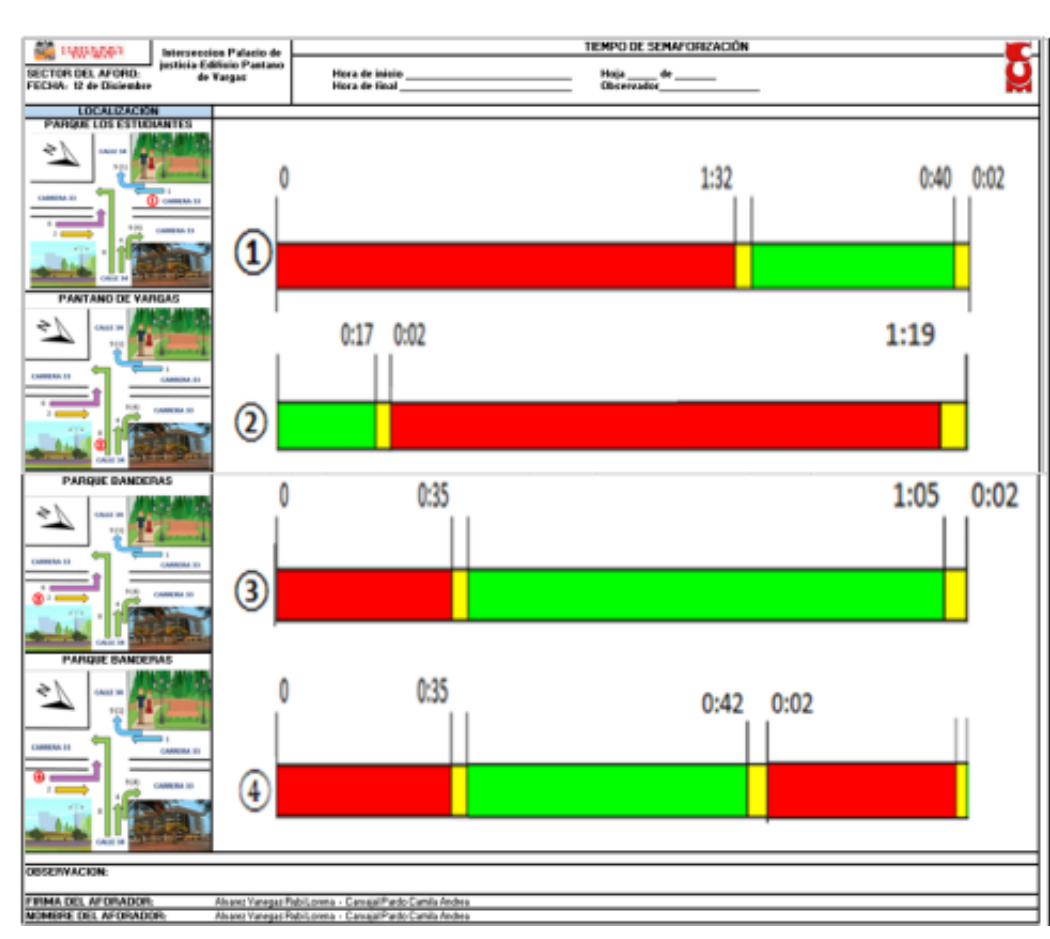
Figure 9: Traffic lights phases for intersection 1 ( Carrera 33 with Calle 34